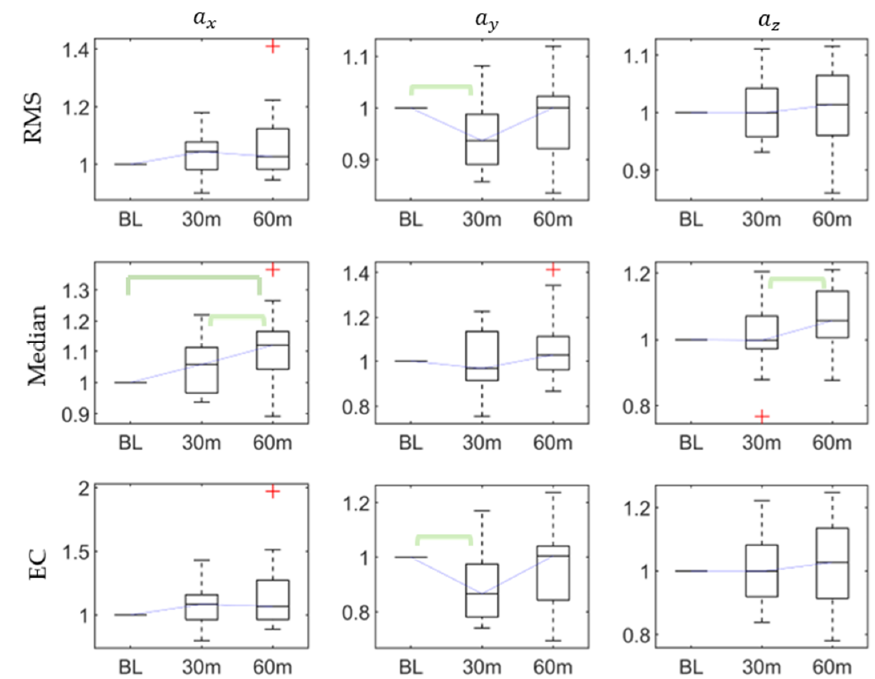
Figure 2. The root mean square (RMS), median, and energy consumption (EC) of accelerations at baseline, 30th min, and 60th min. Bracket denotes statistical significance ( p < 0.05) in the post hoc analysis with Bonferroni correction.